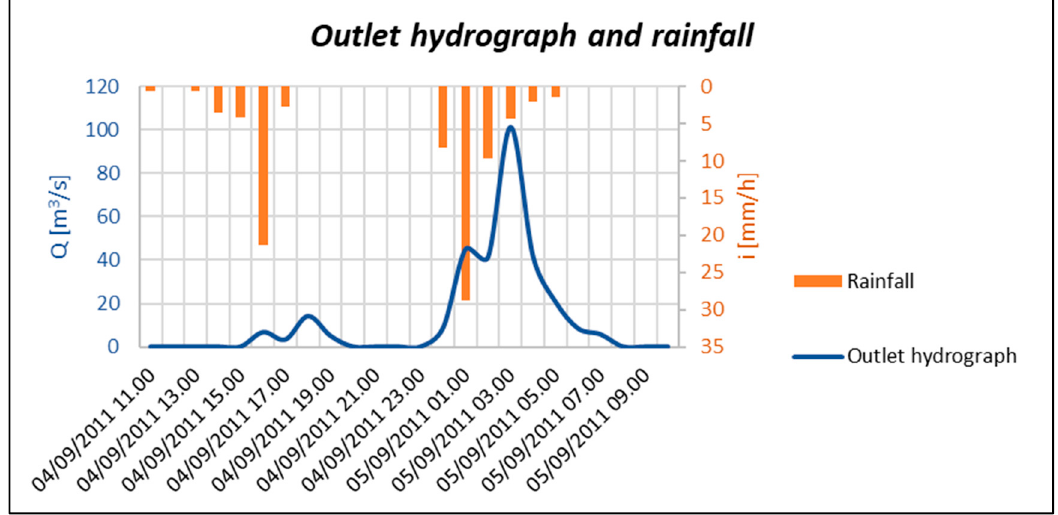
Figure 6. Recorded rainfall at Sarnico station and simulated outlet hydrograph created using AMC II (4 September 2011 rainfall event).